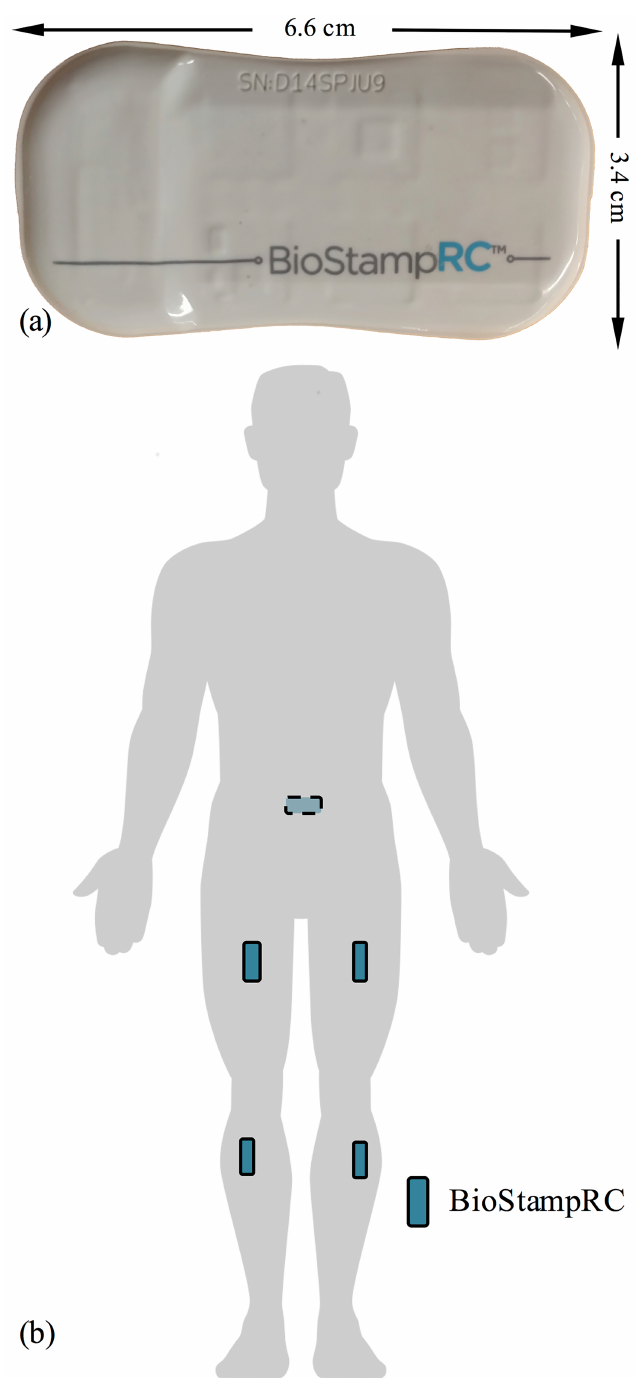
Fig 1. BiostampRC sensors are skin-mounted, conformal devices that can be adhered at multiple locations on the body. (A) BioStampRC skin-mounted, conformalmotion sensor. (B) Anatomical locations where devices were adheredto the